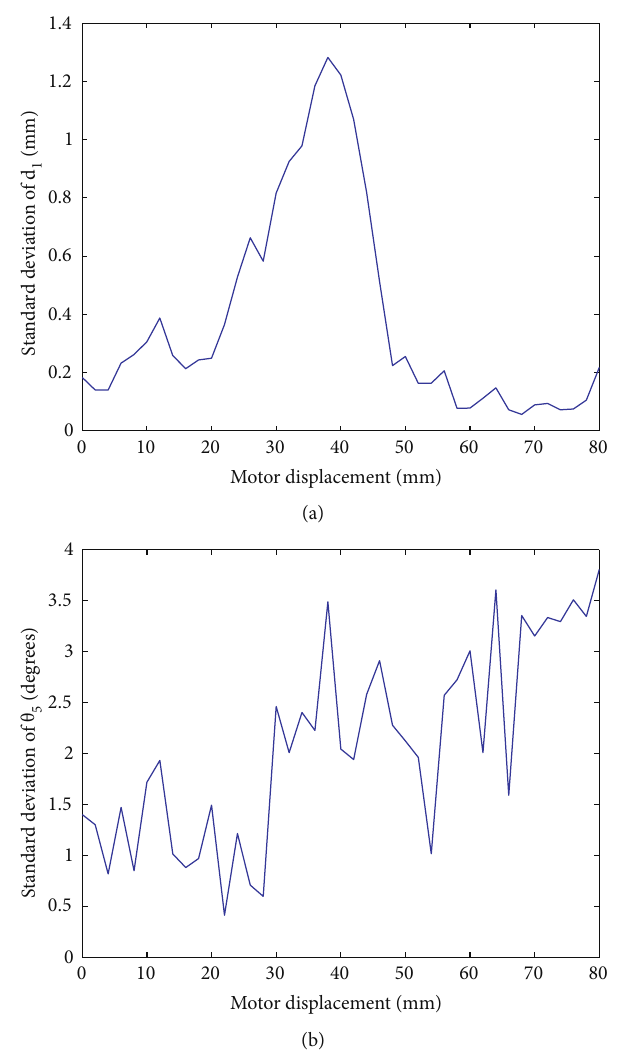
Figure 12: Standard deviation of variables d